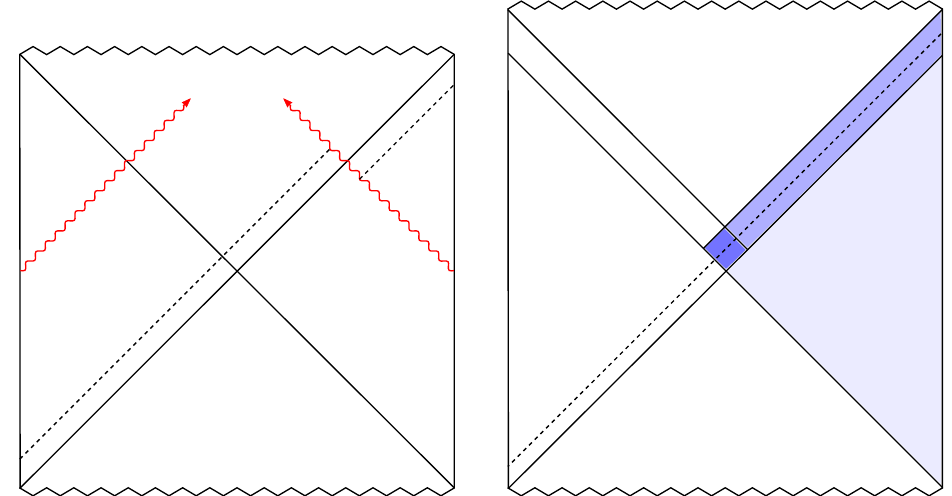
Figure 1: TFD under the double-trace deformation of [ 51 ] . ( Left ) The deformation manifests in the bulk as two negative-energy shockwaves (red wavy lines). A null observer (dashed line) who falls into the black hole from the left suffers a time- advance upon crossing the shockwave, which shifts her to the exterior region on the right. A more physical way of understanding this is that the negative-energy shocks lower the mass of the black hole, thereby causing the future horizon to shrink ( Right ). The result is that the exterior wedge increases in size (from light to dark blue), which opens up a causeway through which the observer can safely travel. Note that the left and right exterior regions are no longer independent, but overlap in the central diamond (darkest blue). The algebraic structure that corresponds to these nested wedges is a modular